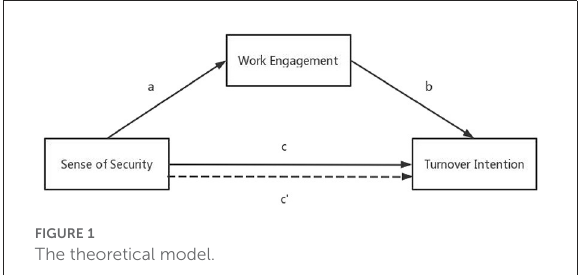
FIGURE1 The theoretical